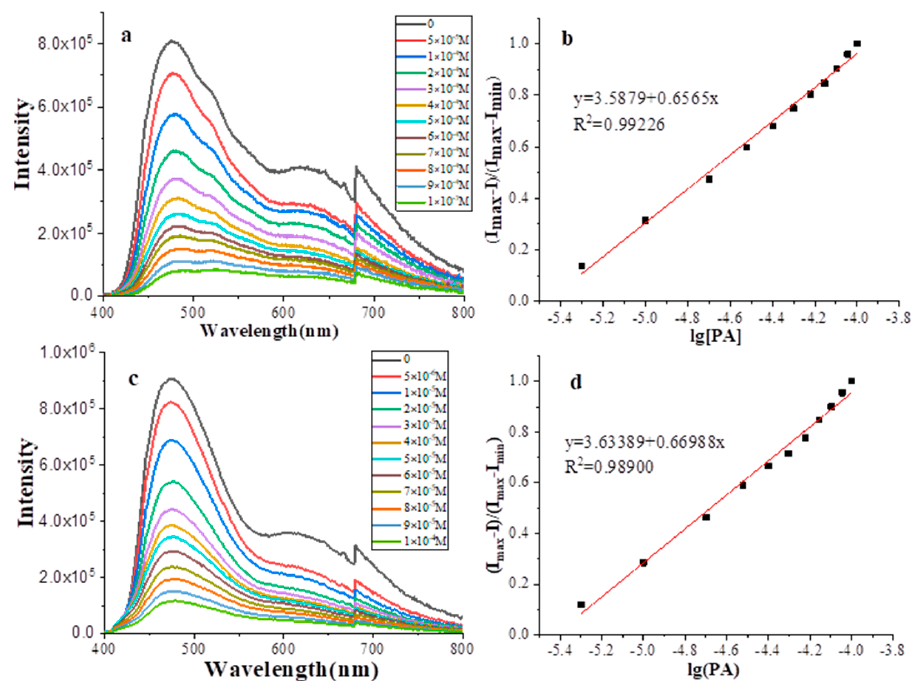
Figure 10. Fluorescence titration spectra of ( a ) CP-shu-1 and ( c ) CP-shu-2 in the presence of different amounts of PA in acetonitrile and the corresponding (I max − I)/(I max − I min ) vs. lg[PA] plot ( b , d ) for the fluorescence titration.